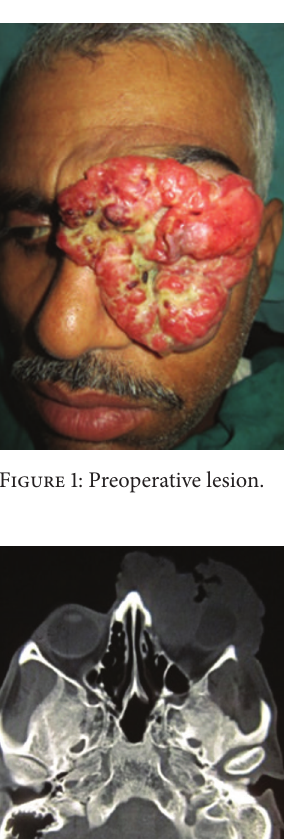
Figure 4: Wide excision of